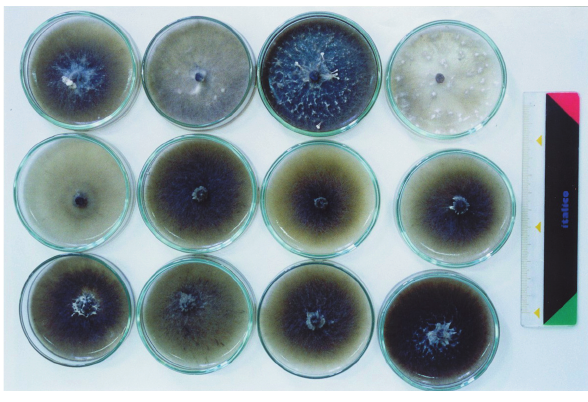
Figure 1 - Isolates of Drechslera tritici-repentis showing morphological variation. (1) E16-Coxilha; (2) CEP24-Selbach; (3) E16-Ronda Alta; (4) BR23-Santa Rosa; (5) E16-Selbach; (6) E15-Lagoa Vermelha; (7) C19- Cruz Alta; (8) E16-Não-Me-Toque; (9) E24-Butiá Gr./Sertão; (10) E16- Não-Me-ToqueII; (11) E16-Vacaria; (12) PF90120- Passo